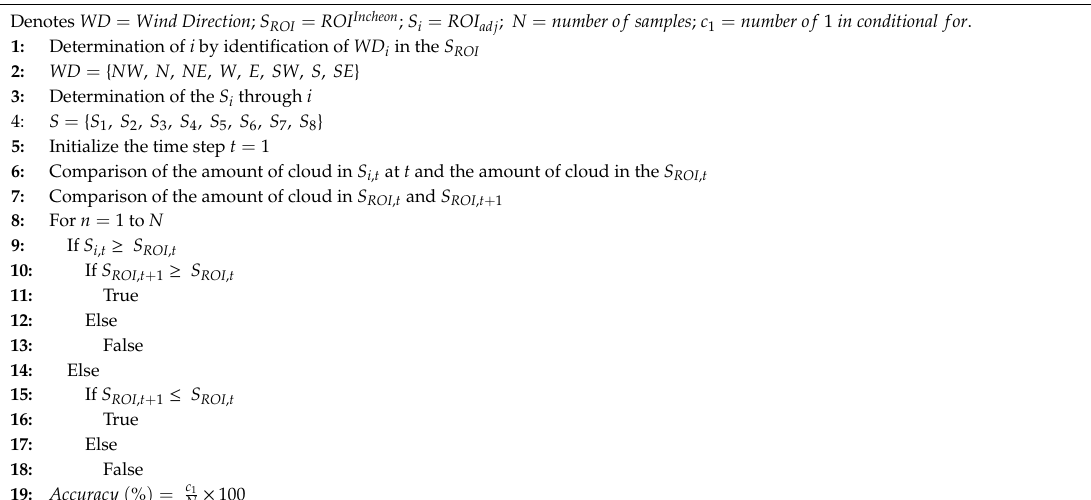
Algorithm 1. Algorithm of discriminant for movement of clouds and PM by wind direction.